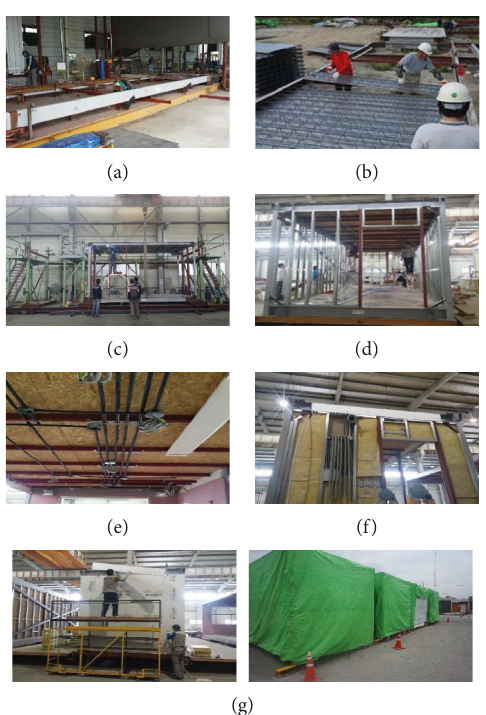
Figure 2: Factory manufacturing process. (a) Manufacturing of the floor frame. (b) Manufacturing of the concrete floor slab. (c) Assembly of the structural frame. (d) Installation of light-weight steel structures. (e) Installation of plumbing and electrical equipment. (f) Installation of inner walls and insulation. (g) Ex- ternal work and open